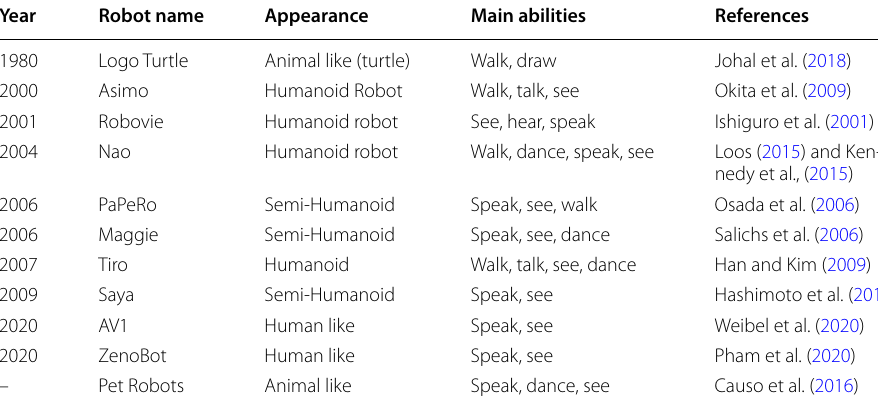
Table 2 Examples of educational robots used over the years